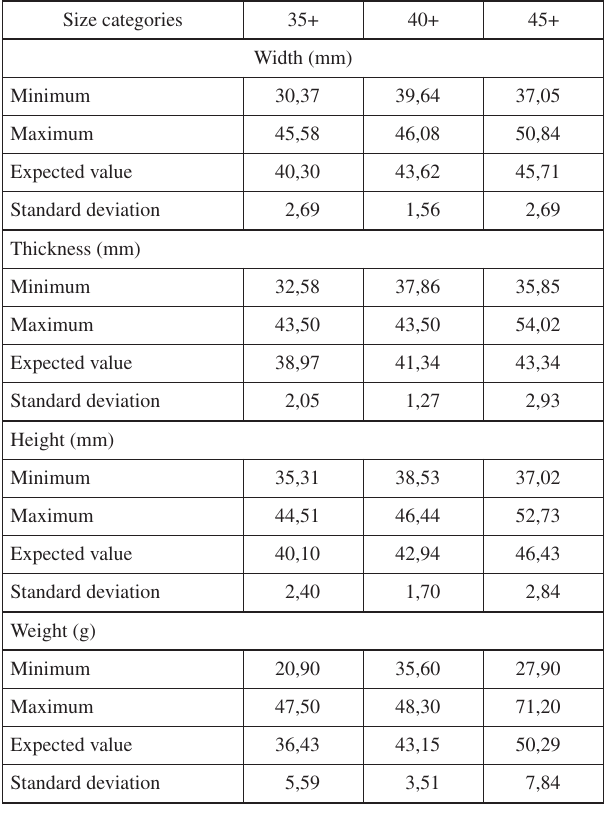
Table 3. Characteristics of Bergerouge apricot